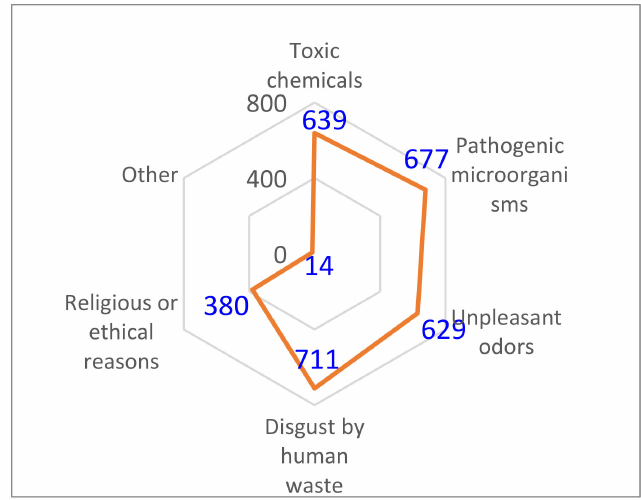
Figure 4. Public reasons of hesitations regarding wastewater